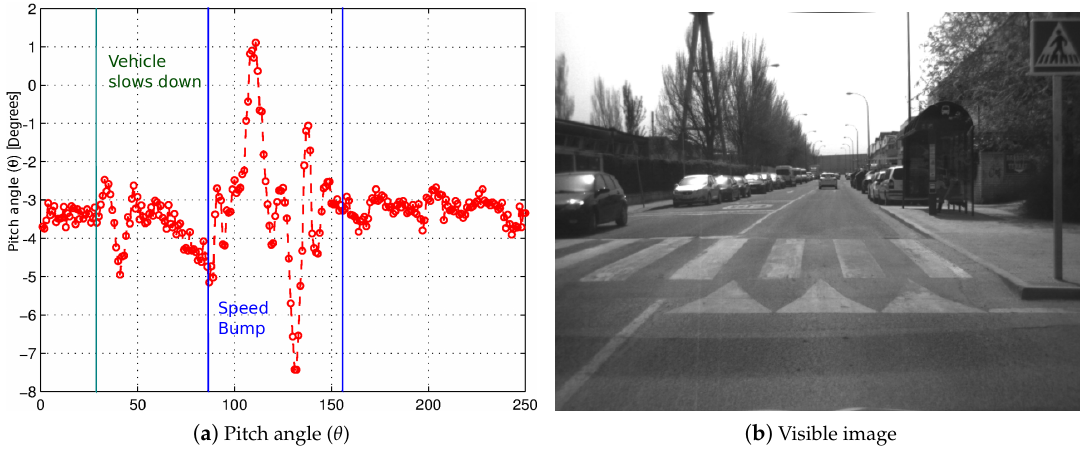
Figure 5. Result of the estimated pitch angle when the vehicle passes through a speed